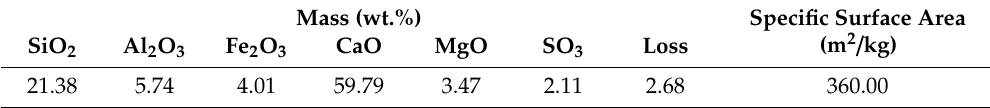
Table 1. Chemical composition and specific-surface area of cement. Mass